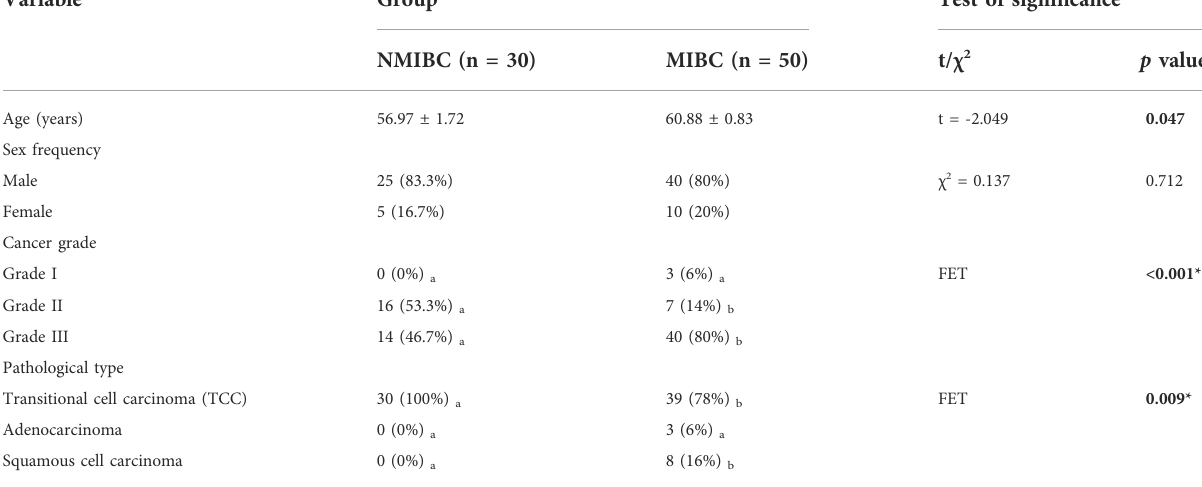
TABLE 1 Patients and tumor characteristics of the two bladder cancer groups: Variable